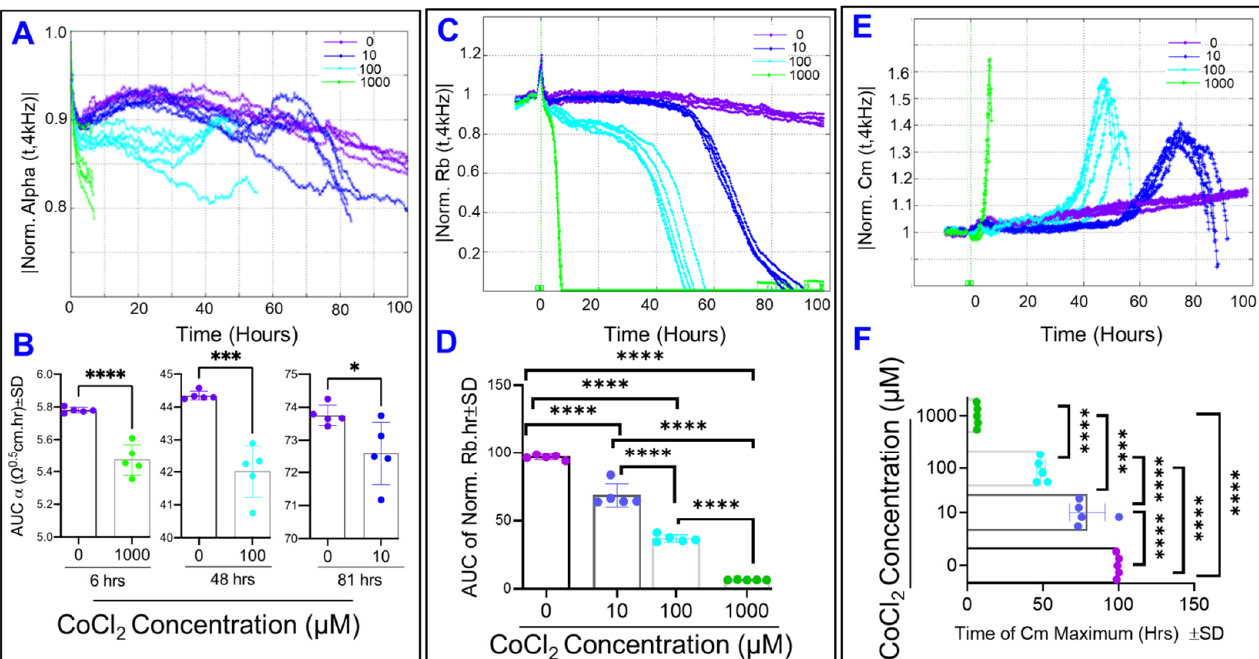
Figure 6. Real-time monitoring of ARPE-19 cells’ α , Rb, and Cm under cytopathic hypoxia. ( A ) Normalized α measured at 4000 Hz vs. time (t) from the time of treatment to T = 100 h after CoCl 2 -treatment at different concentrations (0, 10, 100, and 1000 µM). Considering the curves for the 100 µM and 1000 µM groups, as well as all but one of the curves for the 10 µM group, the curves abruptly end before the 100 h mark is reached. This represents areas where the value could not be modeled as a non-zero or as a positive integer from the total resistance data, as α cannot be calculated when Rb is a non-zero value. The first 10 µM curve to end does so at T = 81 h, the first 100 µM curve to end does so at T = 48 h, and the first 1000 µM curve to end does so at T = 6 h. ( B ) Areas under of normalized α curves. Two tailed t-tests were done to compare treatment group to control, and control is compared to each treatment group at an interval specific to each treatment. The intervals used to calculate the AUCs were as follows: control vs. 10 µM from T = 0 − 81 h; control vs. 100 µM from T = 0–48 h; and control vs. 1000 µM from T = 0–6 h. These comparisons demonstrate that, in each treatment, α has been reduced by time RB has reached zero. ( C ) Normalized Rb measured at 4000 Hz vs. time (t) from the time of treatment to T = 100 h after CoCl 2 -treatment at different concentrations (0, 10, 100, and 1000 µM). ( D ) Areas under the normalized Rb curve from T = 0–100 h. ANOVA for all groups, demonstrates how Rb also responds to CoCl 2 with reductions in a dose-dependent fashion. ( E ) Normalized Cm measured at 4000 Hz vs. time (t) from the time of treatment to T = 100 h after CoCl 2 -treatment at different concentrations (0, 10, 100, and 1000 µM). ( F ) Time to maximum value for normalized Cm curve from T = 0–100 h. ANOVA for all groups, demonstrates how C m responds to CoCl 2 in a dose-dependent fashion. Abbreviations: Norm, normalized; AUC, area under the curve. Data shown are the mean ± SD of 5 independent biological replicates ( n = 5/group); p values are * p ≤ 0.05, *** p ≤ 0.001, and **** p ≤ 0.0001.